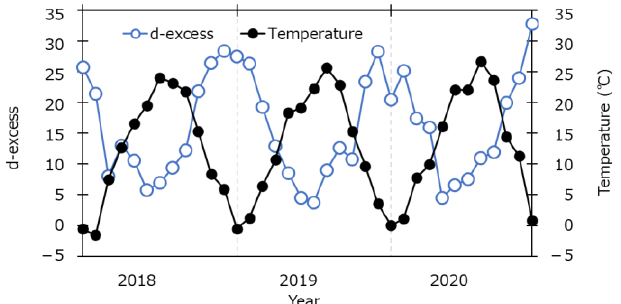
Figure 9. Variations in the d-excess and temperature in the monthly precipitation at Hirosaki City (2018 to 2020).